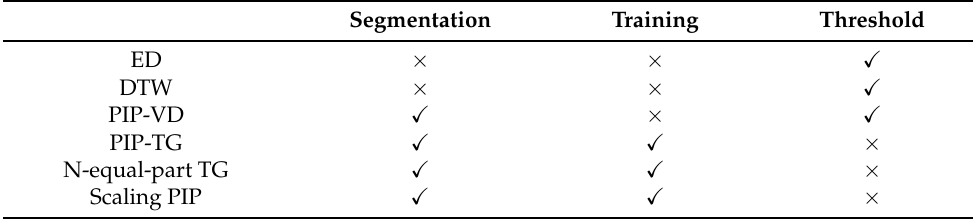
Table 1. The characteristics of each